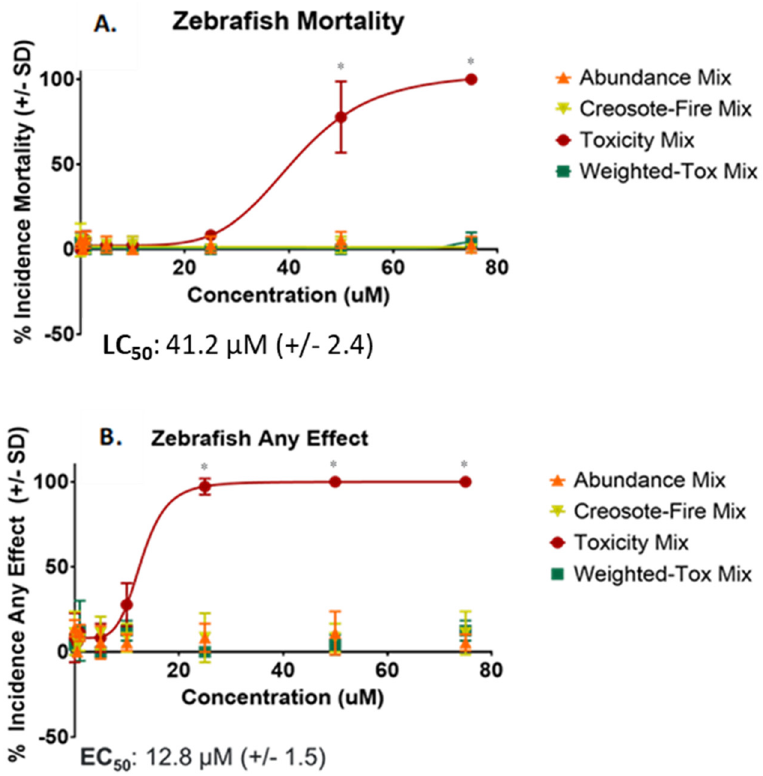
Figure 6. Concentration-Response Curves for Mortality and Any Effect in Zebrafish. ( A ) Percent incidence of Zebrafish mortality and predicted LC 50 and ( B ) Percent incidence of any effect and predicted EC 50 value. Toxicity Mix was the only mixture with significant bioactivity in zebrafish. Any concentration at or above binomial significance threshold are denoted with an asterisk (*).